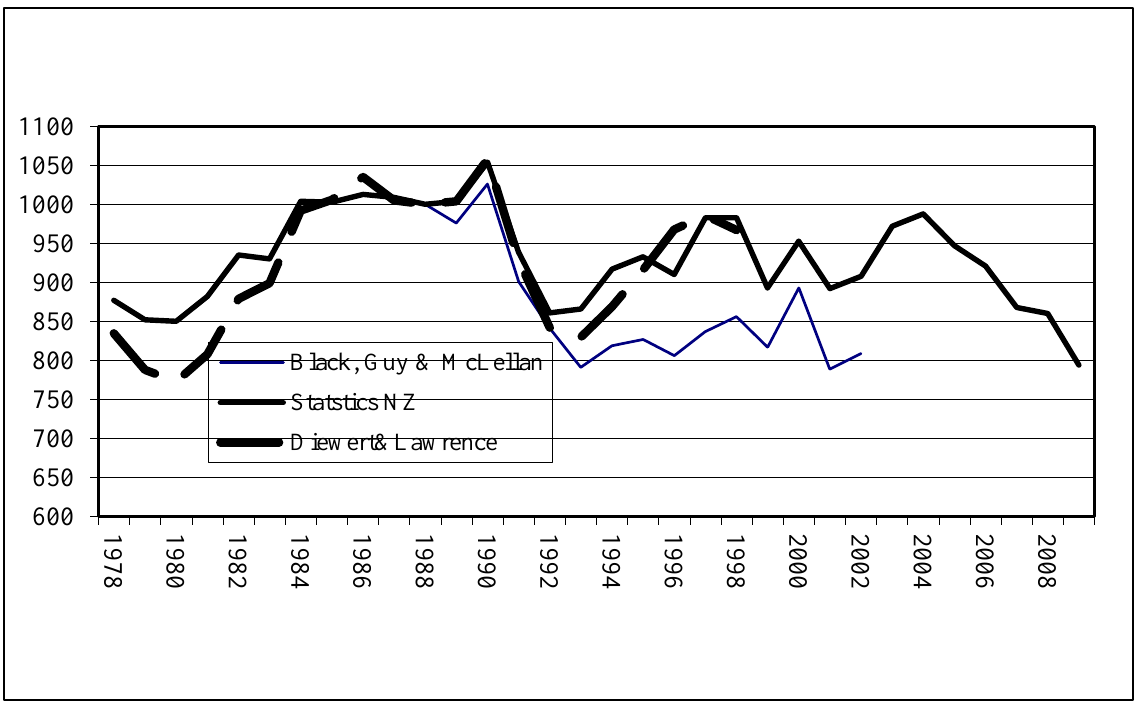
Figure 2 Total factor productivity of the New Zealand, 1978=1000 construction industry Source: Statistics New Zealand 2012, Industry productivity statistics. Diewert & Lawrence 1999, Black, Guy & McLellan